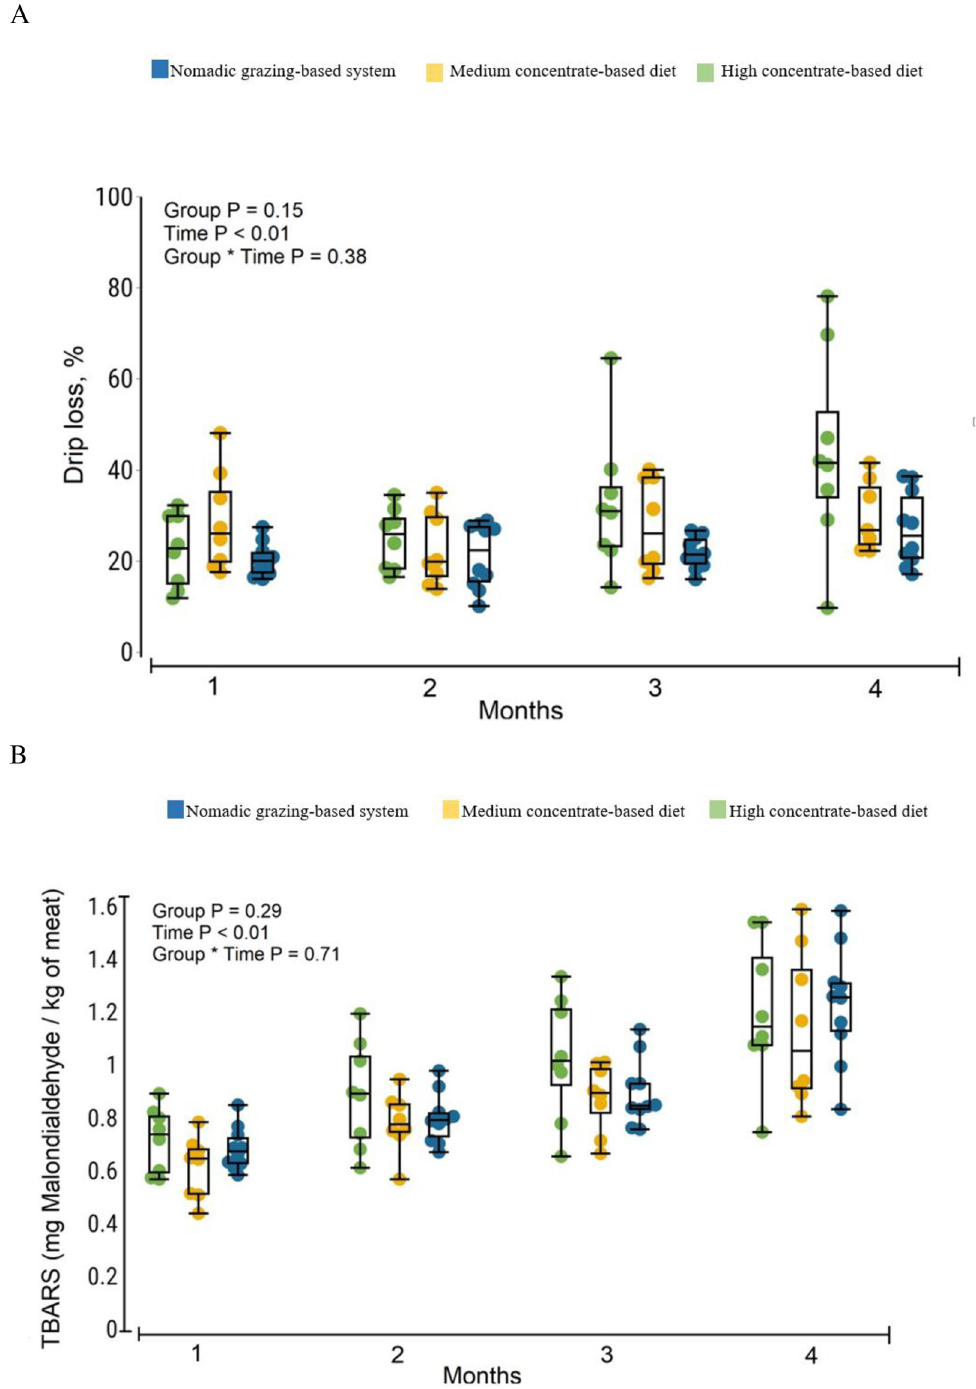
Fig 3. (A) Drip loss (%) and (B) Thiobarbituric acid reacting substances (TBARS) formation (mg malondialdehyde per kg meat) in M. longissimus dorsi in lambs fed nomadic-grazing based system, medium concentrate-based diet, and high concentrate-based diet (n = 10